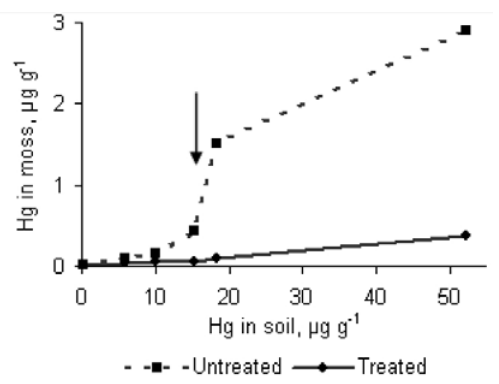
Fig. 2 Hg content in moss Sphagnum Magellanicum on the 9 th day of the experiment, untreated and treated